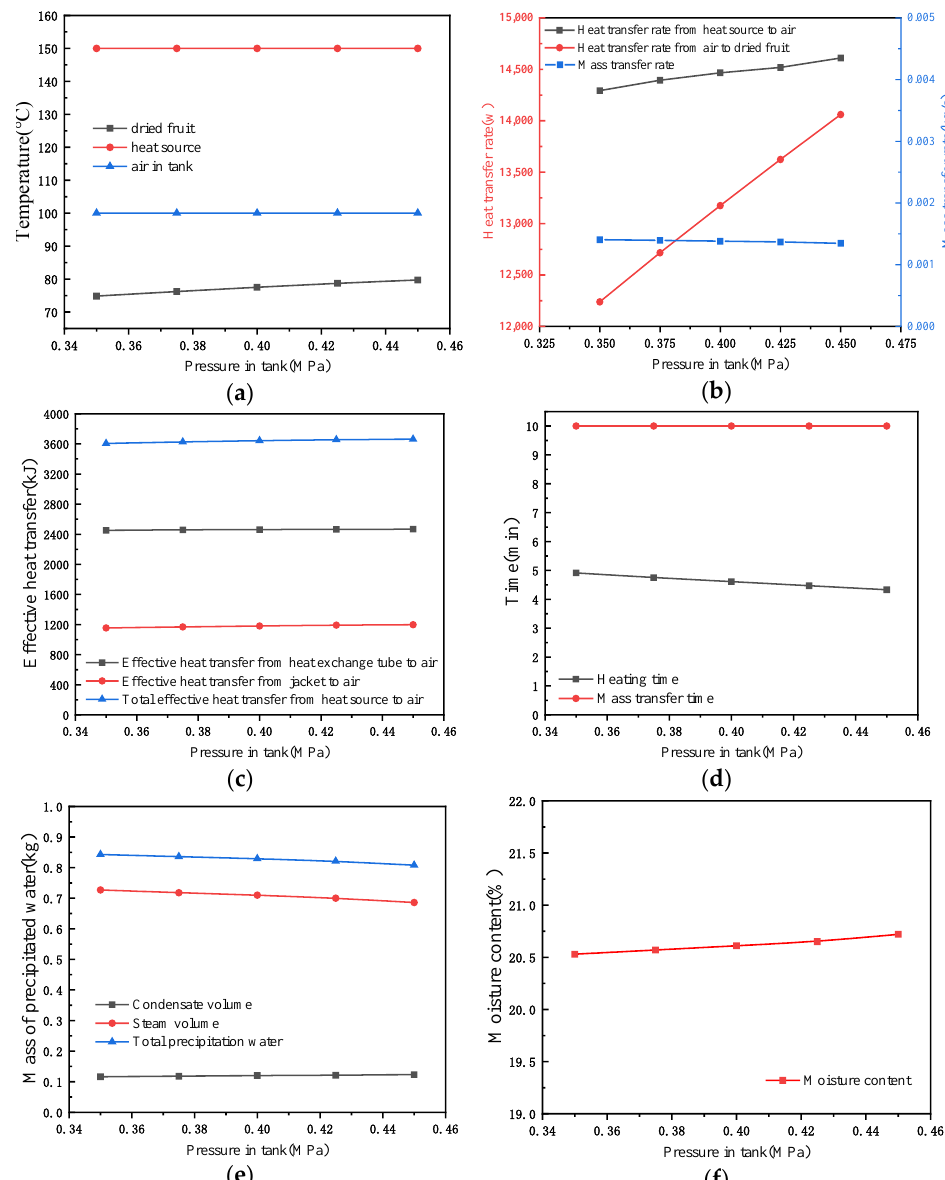
Figure 3. Effect of tank pressure on heat and mass transfer performance. ( a ) Effect of pressure in tank on temperature. ( b ) Influence of pressure in tank on heat and mass transfer power. ( c ) Effect of pressure in tank on heat transfer. ( d ) Effect of tank pressure on heating time. ( e ) Influence of pressure in tank on precipitation and condensation water. ( f ) Effect of pressure in tank on moisture content of dried fruit.